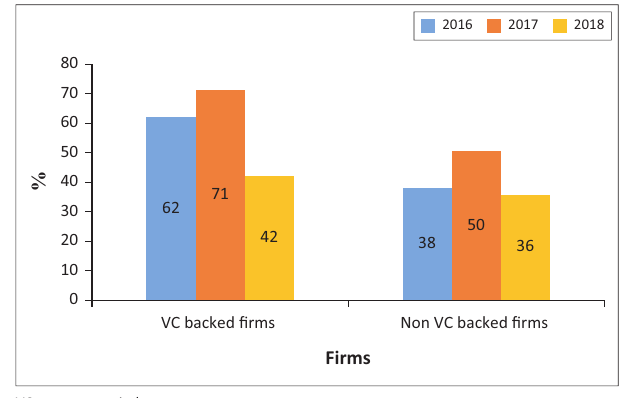
VC, venture capital. FIGURE 2: Asset growth for VC-backed and non-VC-backed firms for 3 years, from 2016 to